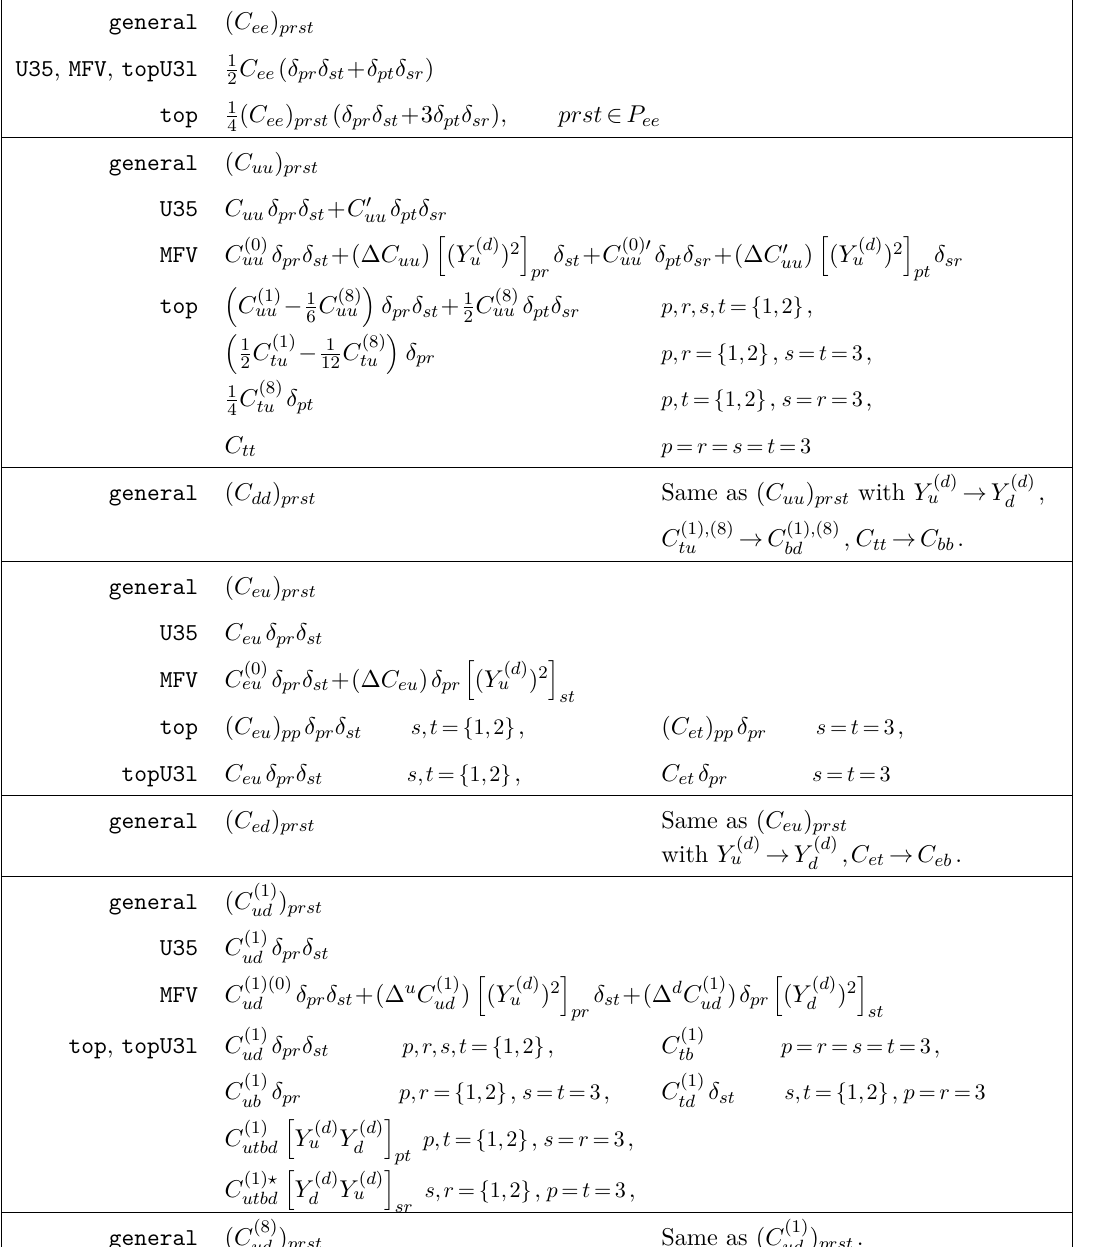
Table 13 . Conversion table among the 5 flavor assumptions considered, for the operators in L (8 b ) The set P is defined in eq. ee